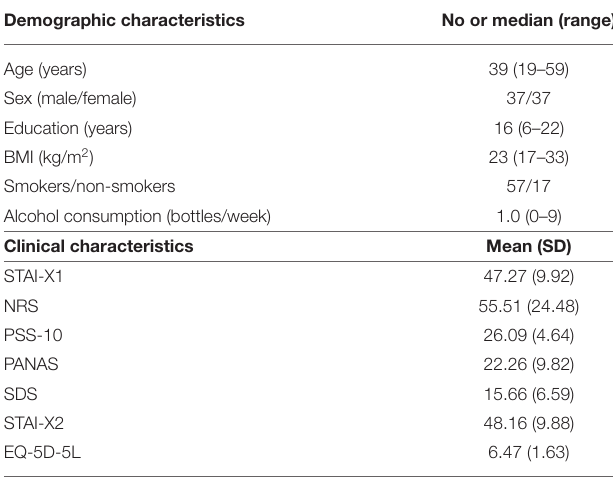
TABLE 1 | Baseline demographic and clinical characteristics of participants ( n =